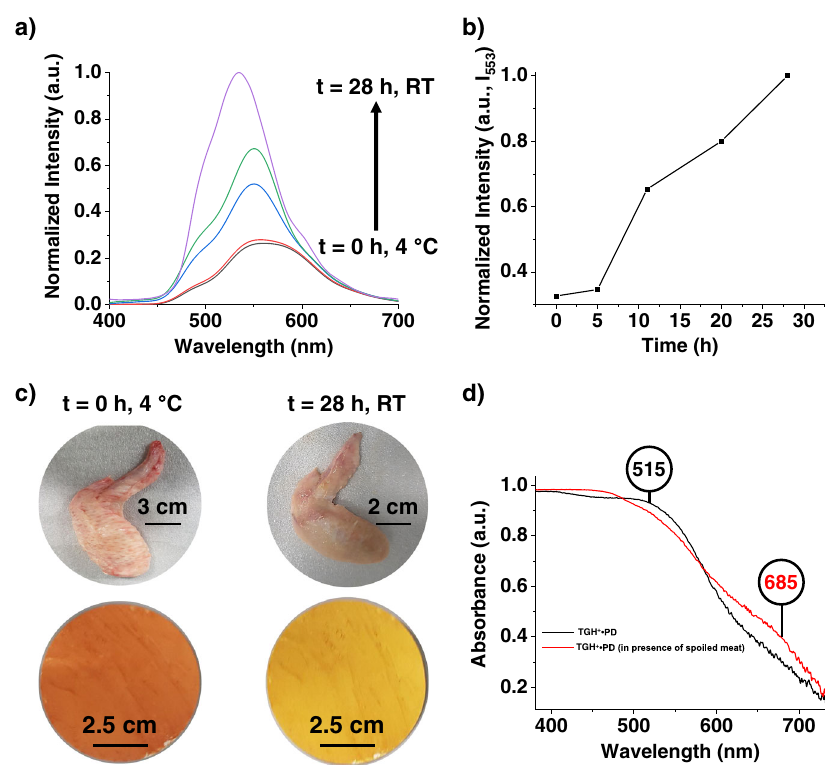
Fig. 5 Monitoring the meat freshness visually by TGH + (cid:129) PD COF. a Emission response of a TGH + (cid:129) PD dispersion in water at different time intervals in the presence of a chicken wing kept at room temperature (RT). b Fluorescence intensity values were measured over different exposure times at room temperature. c Photographs of fi lter paper coated with TGH + (cid:129) PD powder when exposed to fresh (left) and spoiled (right) chicken meat. d Overlaid solid- state UV – Vis spectra of a TGH + (cid:129) PD-coated test strip, recorded at room temperature in the presence of fresh and spoiled chicken